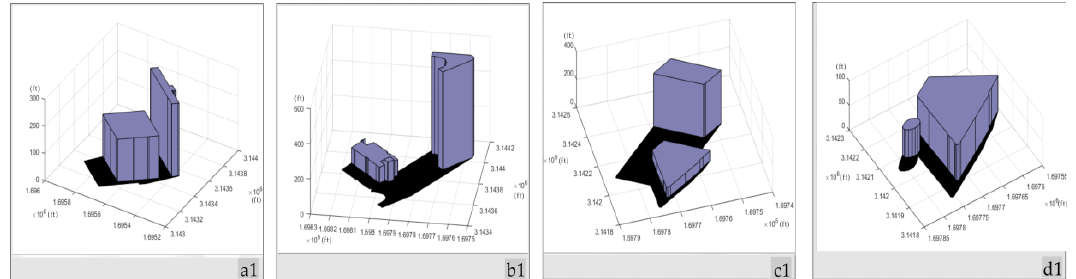
Figure 9. Detected shadow areas on the ground through DBM with gray values assigned to zero (i.e., black).